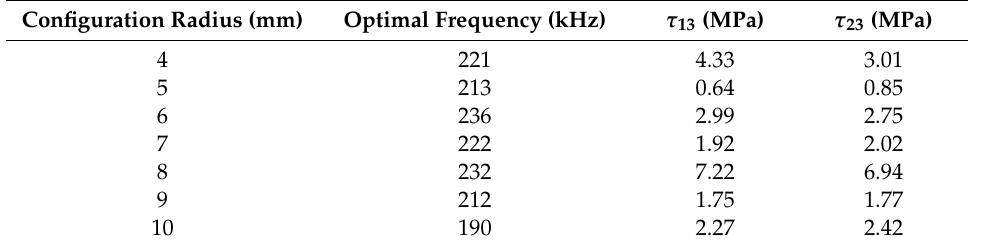
Table 3. Optimal frequency and the average shear stresses at the interface for seven configurations.